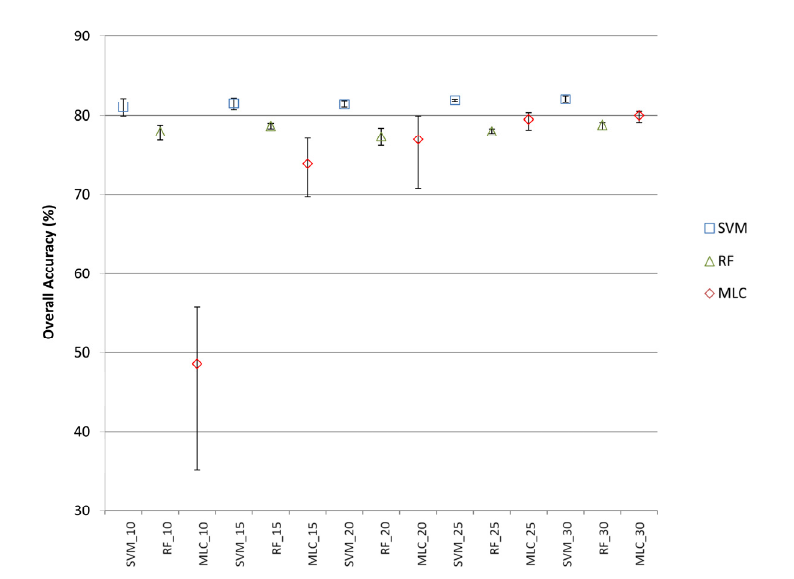
Figure 8. Overall accuracies of SVM, RF and MLC classifier using nine MNF-transformed bands and different number of random training pixels ( N = 10; 15; 20; 25 or 30) from each vegetation